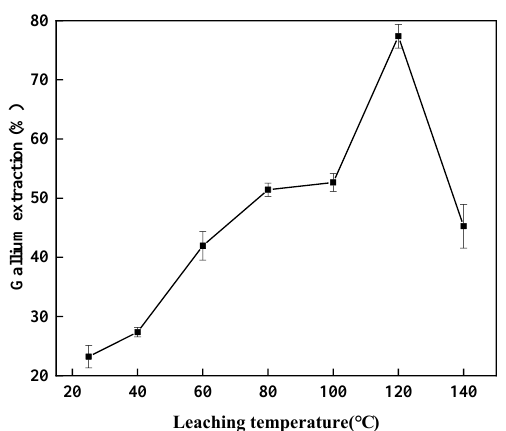
Figure 8. Influence of acid leaching temperature on gallium extraction (the NaF-CFA mass ratio of 0.75:1, roasting temperature of 800 °C, roasting time of 10 min, leaching time of 2 h, and HNO 3 concentration of 2 mol/L).